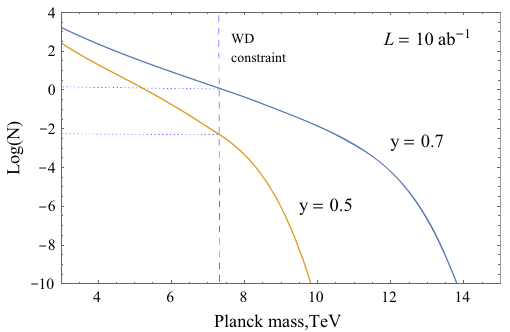
Fig. 8 The constraint from white dwarfs on the number of the neutral black holes, trapped inside the Earth experimentally. Now the highest energy of the detected astro- physical neutrino does not exceed 10 4 TeV